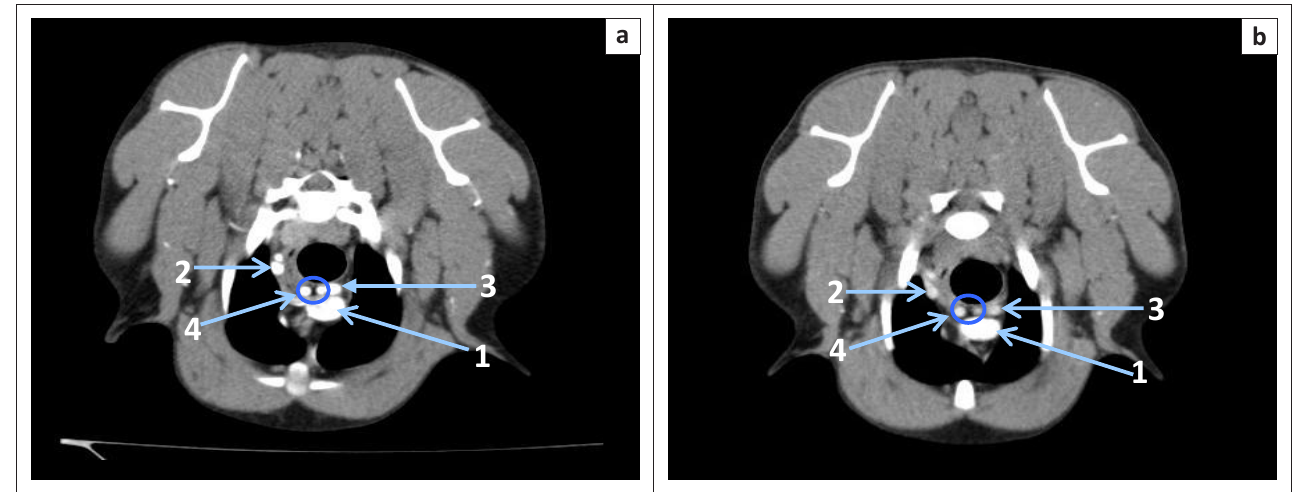
1, cranial vena cava; 2, left subclavian artery; 3, right subclavian artery; 4, left and right common carotid arteries. Left of the dog is to the left of the image. Window width, 400; window length, 40. FIGURE 3: Transverse post-contrast image of dog 5 at the level of the second rib (a) BT arterial and (b) TB